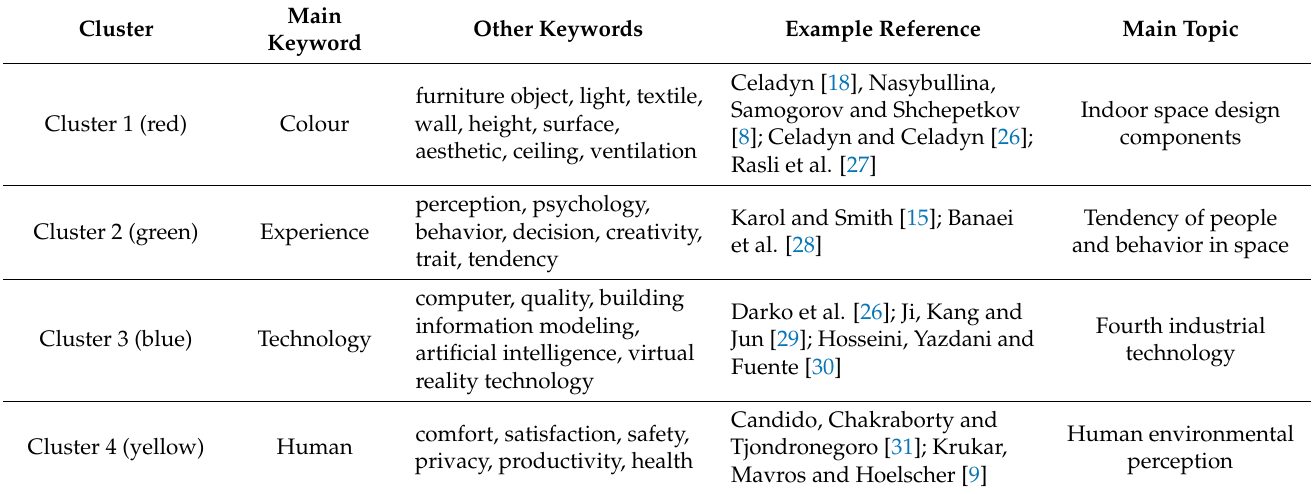
Table 2. Cluster results through network analysis for